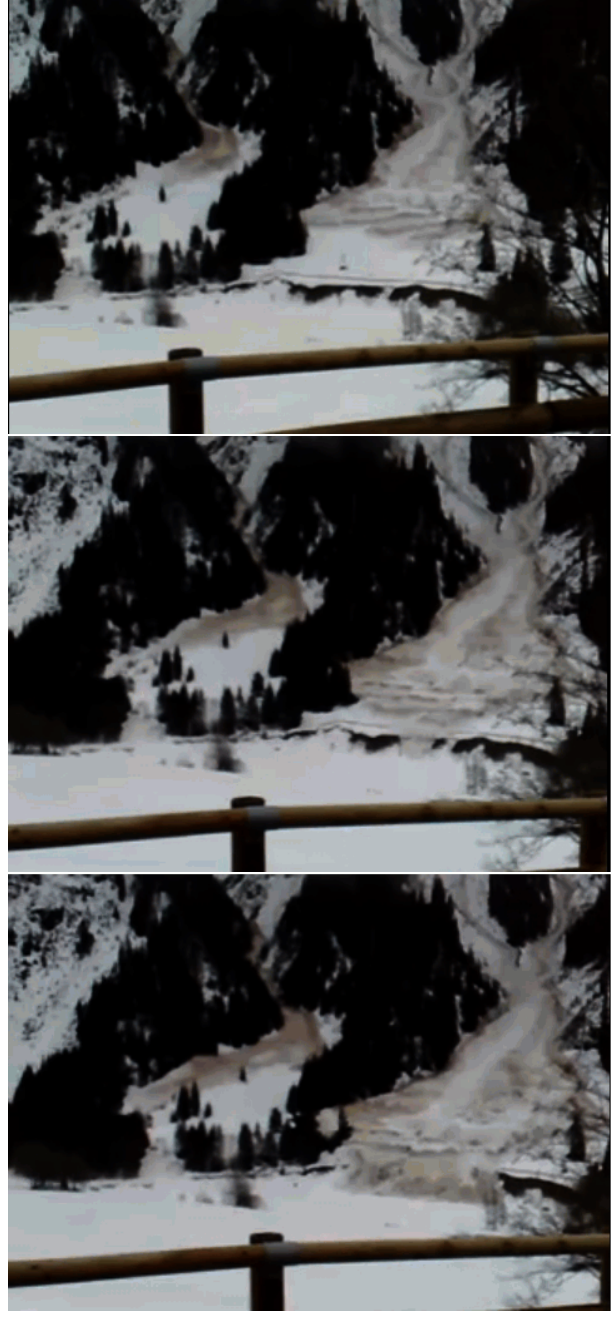
Fig. 6. Video frames of the Gatschiefer event of April 2008 (www. youtube.com). Upper panel: the avalanche was characterized by a series of roll waves. Middle and lower panels: the avalanche was probably characterized by a saturated snow-water